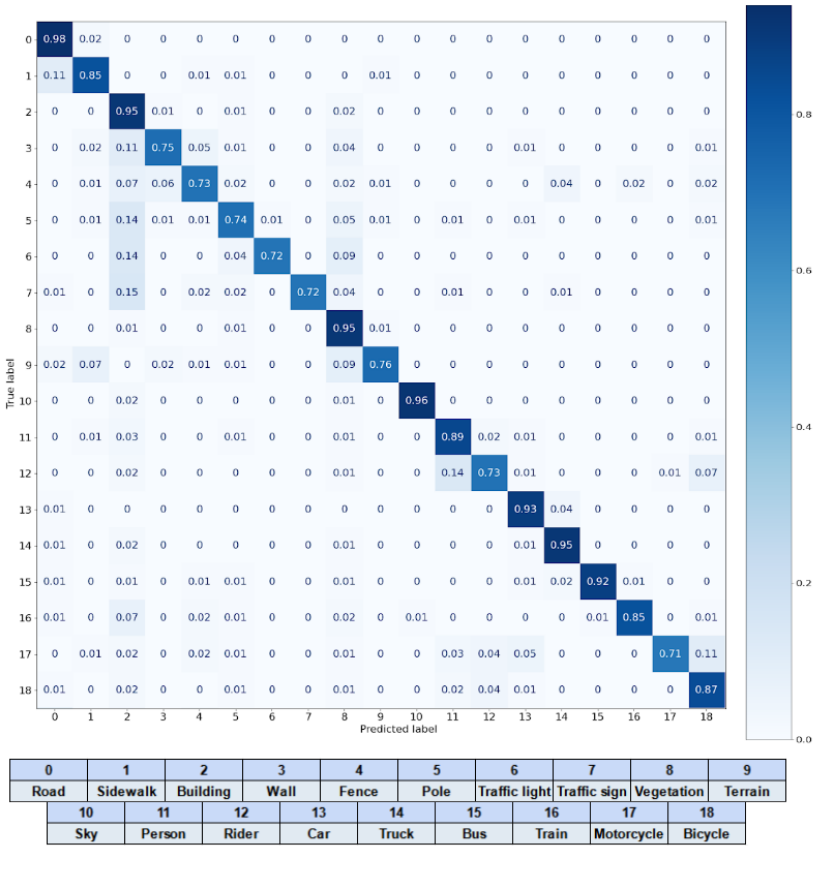
Figure A1. Confusion matrix of the co-training model trained with GTAV + Synscapes as source data and Cityscapes as target